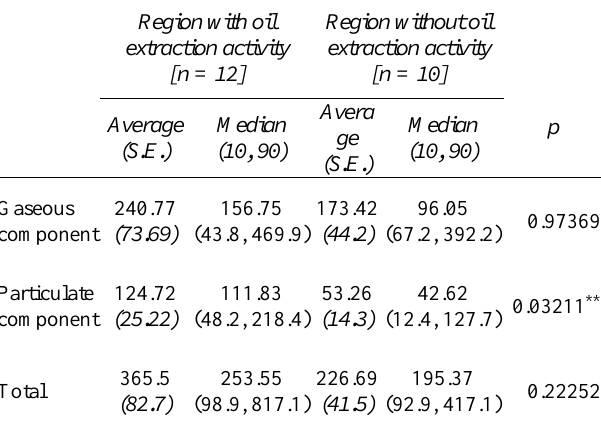
Table 2 :Distribution of total PAHs concentration (ng m -3 ) in the gaseous and particulate components of two regions in the state of Tabasco with different oil